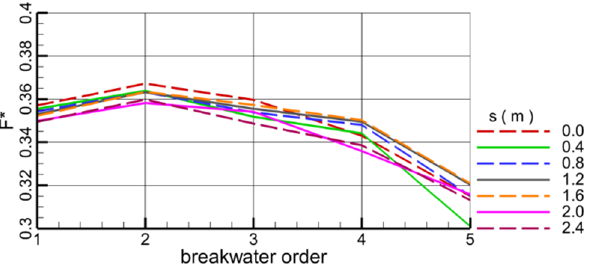
Figure 18. The maximum forces on the breakwaters with different distances.